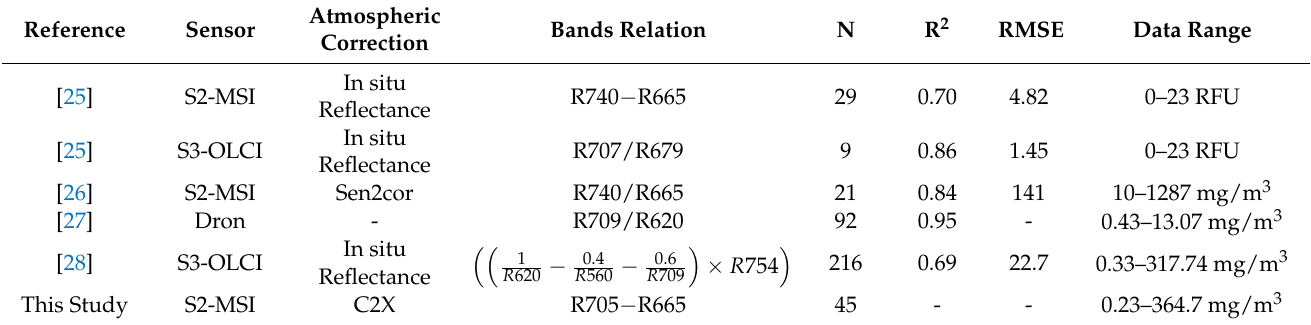
Table 2. Reference equations for the study and corresponding values. N: number of data; R 2 : Pearson determination coefficient; RMSE: Root mean square